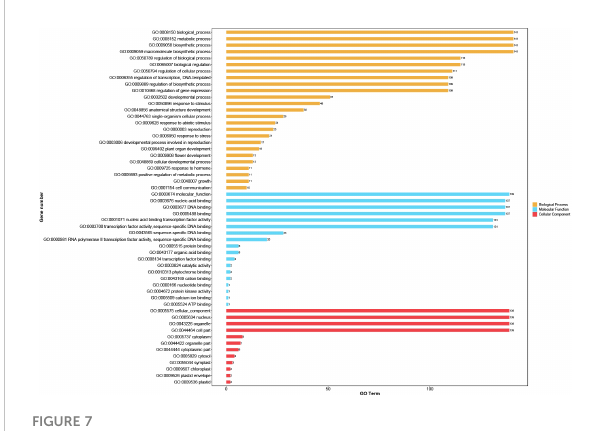
FIGURE 7 Cis-regulatory elements in the promoter region of CpbHLH genes.